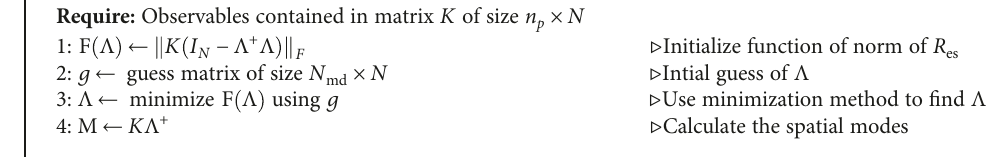
Algorithm 1: NU-DMD for uniform in time data (using just K ).